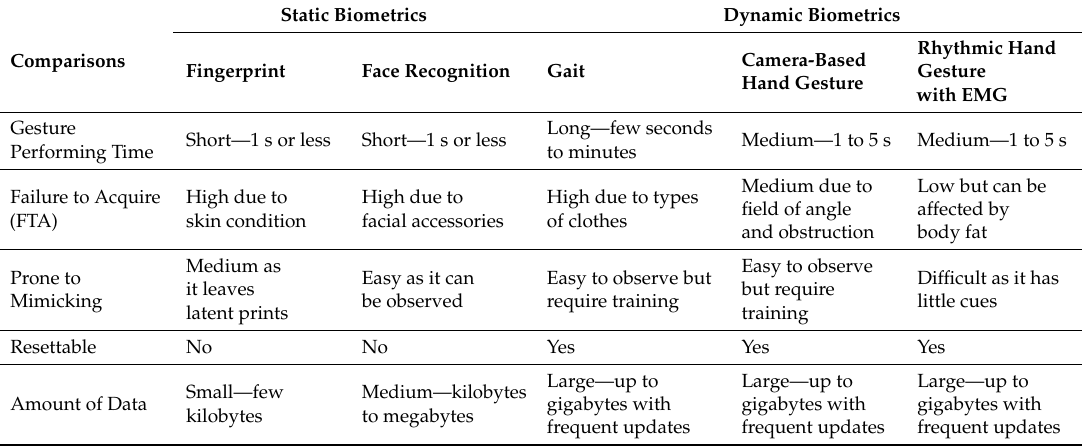
Table 1. Comparisons between different types of